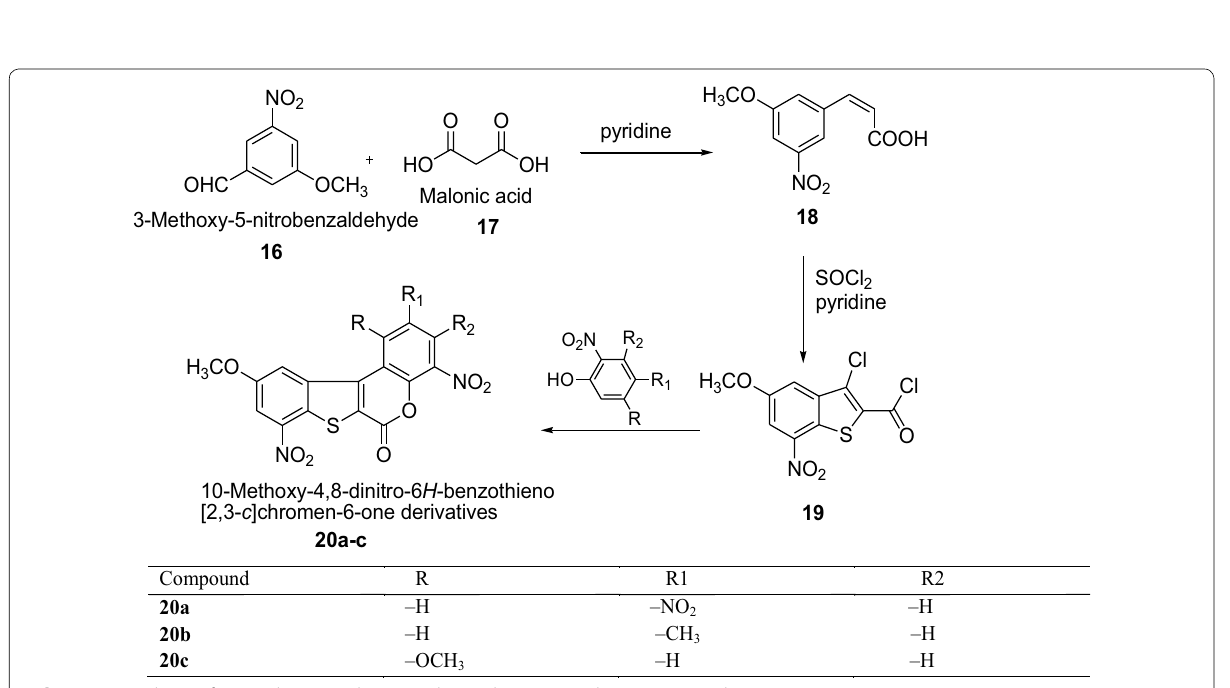
) 11–14 mm [weakly active]; ( +